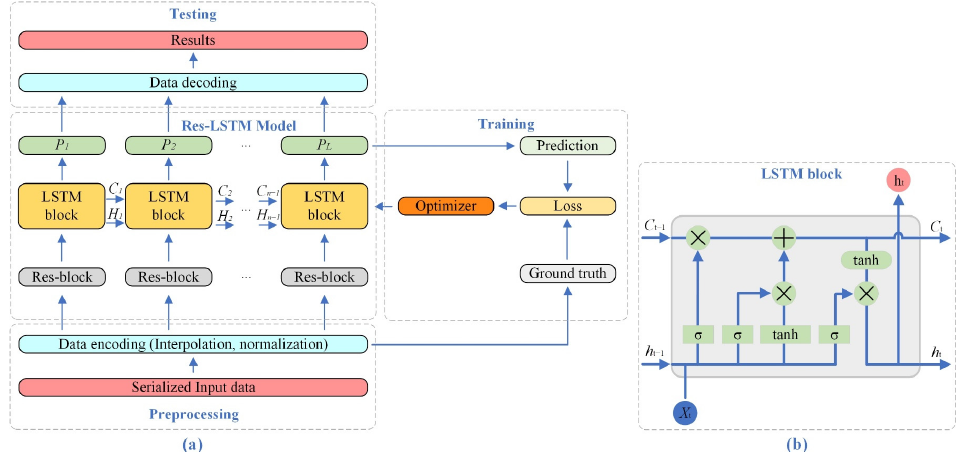
Figure 1. The proposed state prediction network based on Resnet and LSTM. Subplots ( a , b ) represent the proposed network architecture and LSTM block, respectively. The LSTM block displayed in Figure 1 consists of four gates: forget gate, input gate, update gate and output gate.